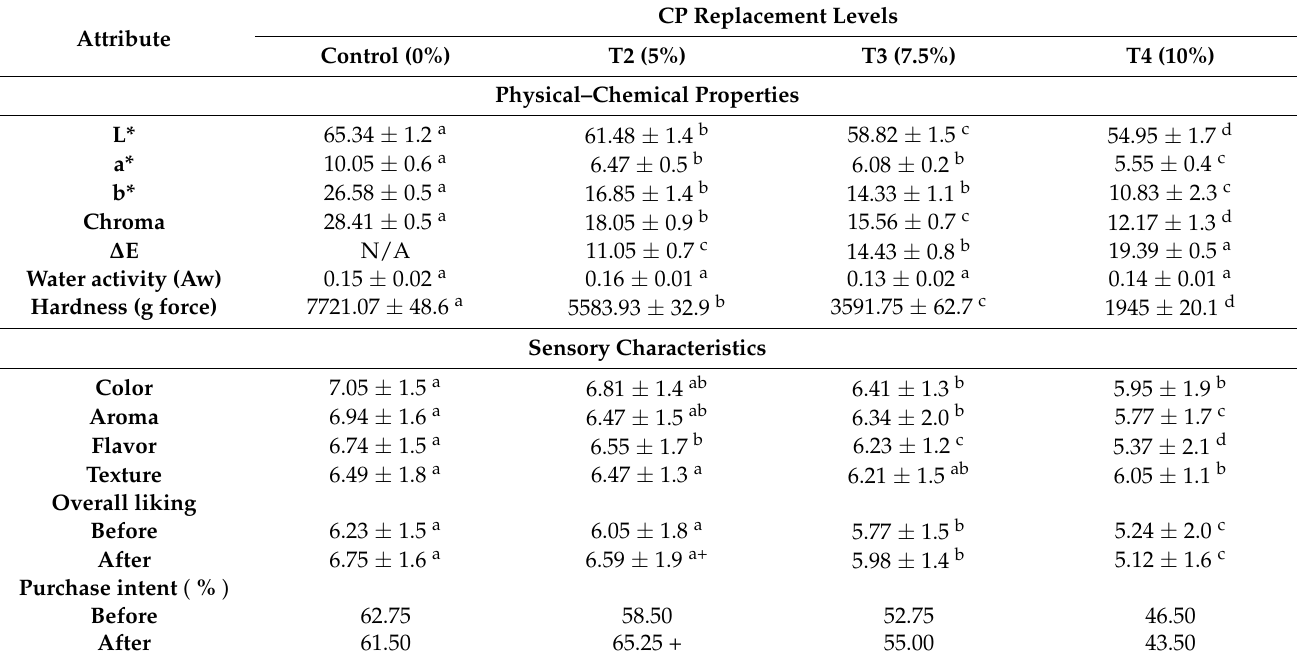
Table 5. Physical–chemical properties and sensory characteristics of chocolate cookies with CP replacement